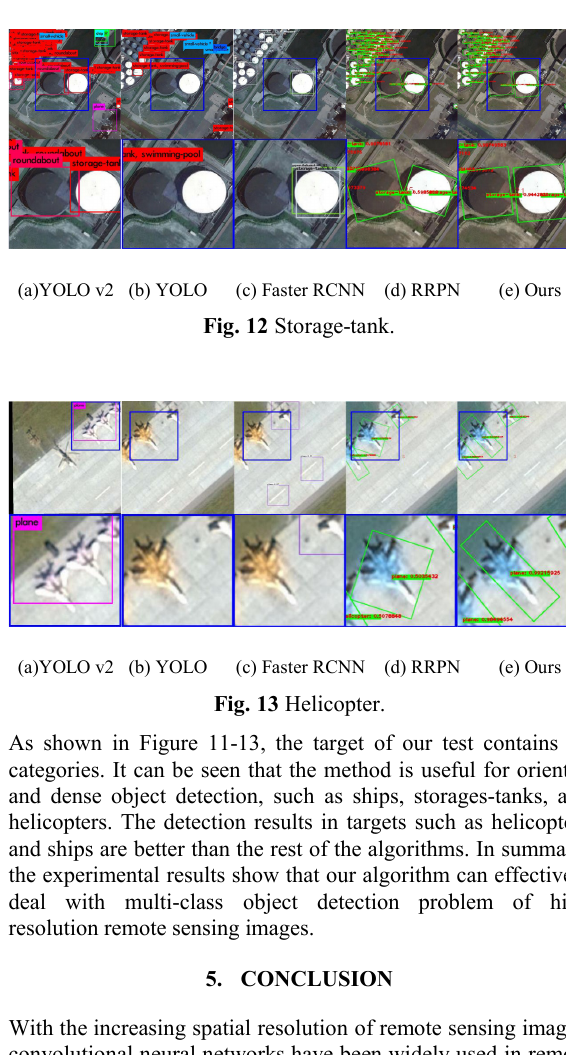
Table 3. Different algorithm comparison